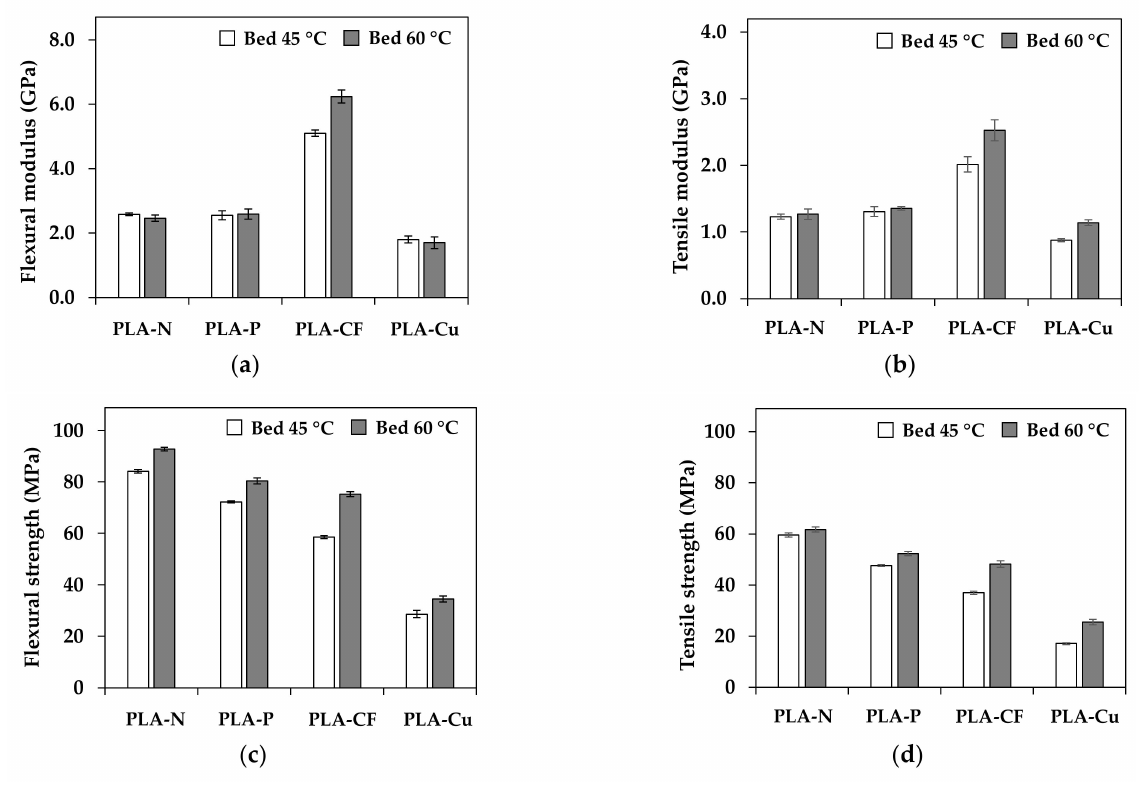
Figure 11. Flexural and tensile properties of 3D printed samples: ( a ) flexural modulus; ( b ) flexural strength; ( c ) tensile modulus; and ( d ) tensile